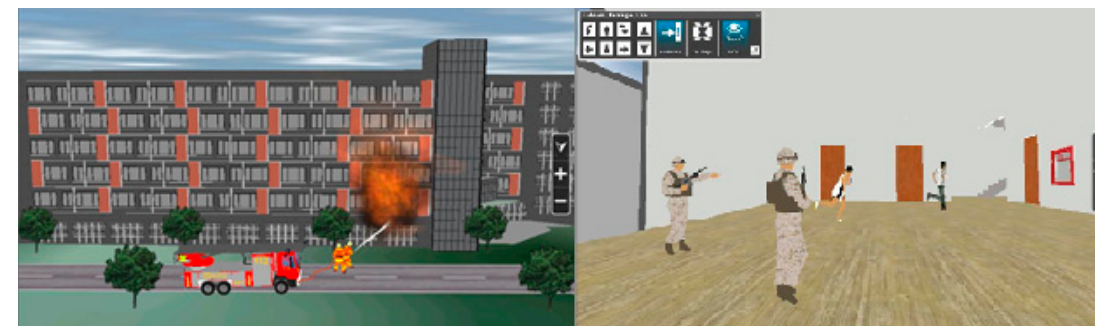
Figure 5. The application interfaces of the indoor and outdoor positioning service system.